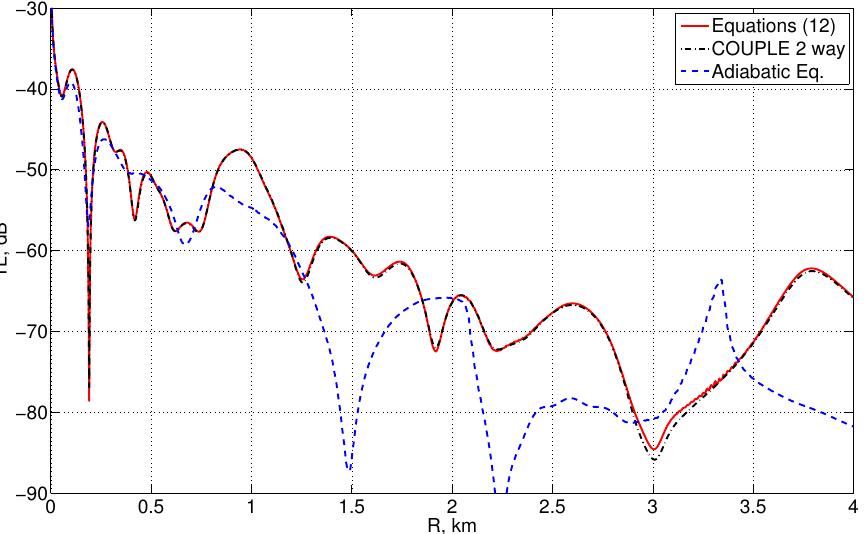
Figure 2. Transmission loss for the propagation along the bottom slope as a function of distance r from the source in ASA wedge benchmark computed by solving equations for mode amplitudes (23). The reference solution is obtained by the COUPLE program [24]. Adiabatic solution is shown for comparison. The source is deployed at the depth of 100 m, and the depth of the receiver is 150